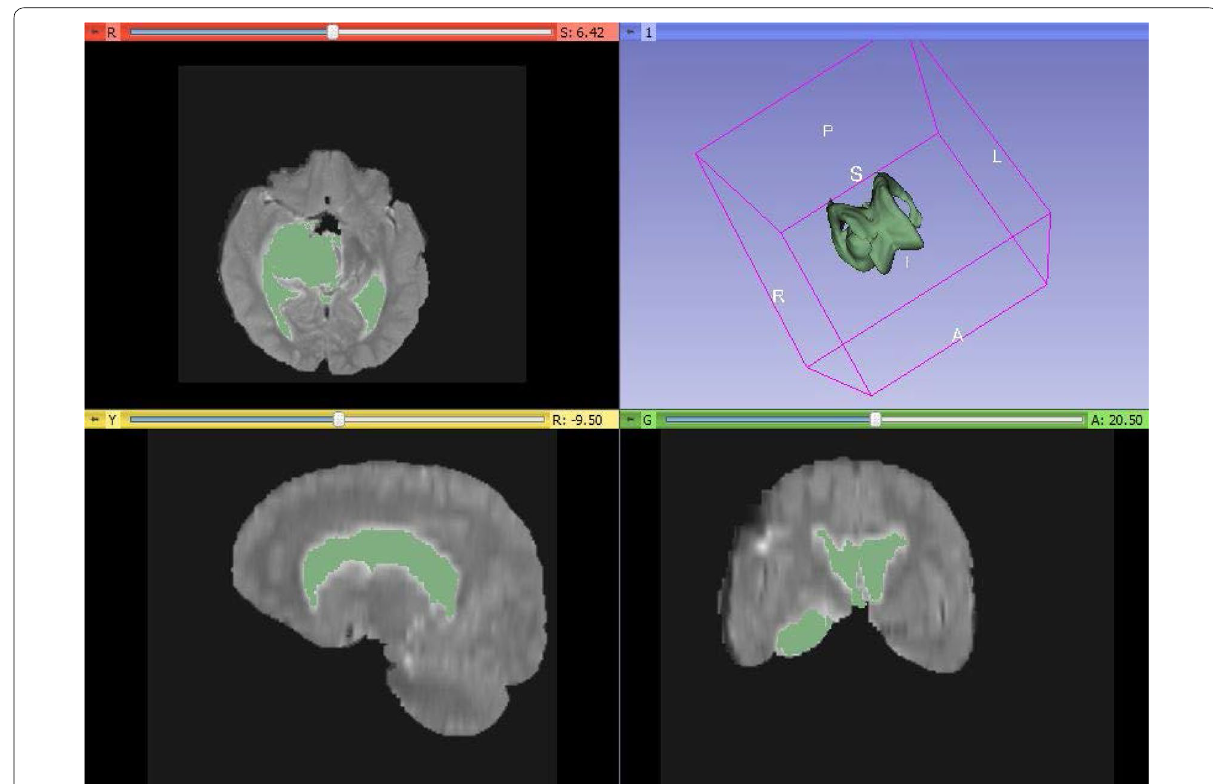
Fig. 7 Experimental result of watershed segmentation (from top to bottom). all slices with the tumor in 3D, watershed result of brain tumor image (red slice only), tumor in 3D view